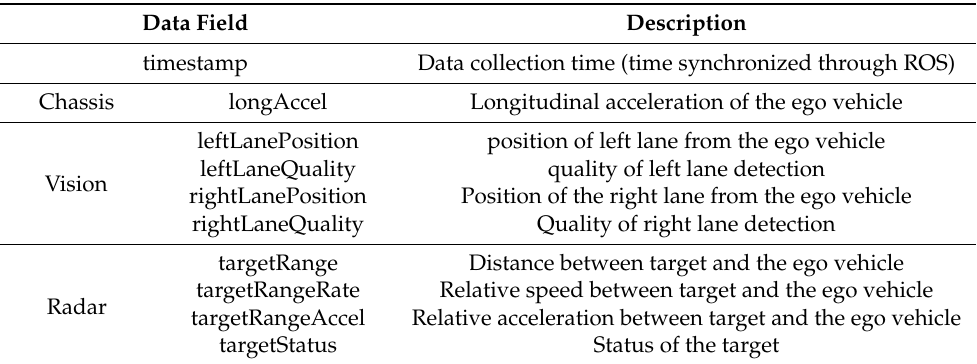
Table 1. Description of the data collected by the connected and automated vehicle.